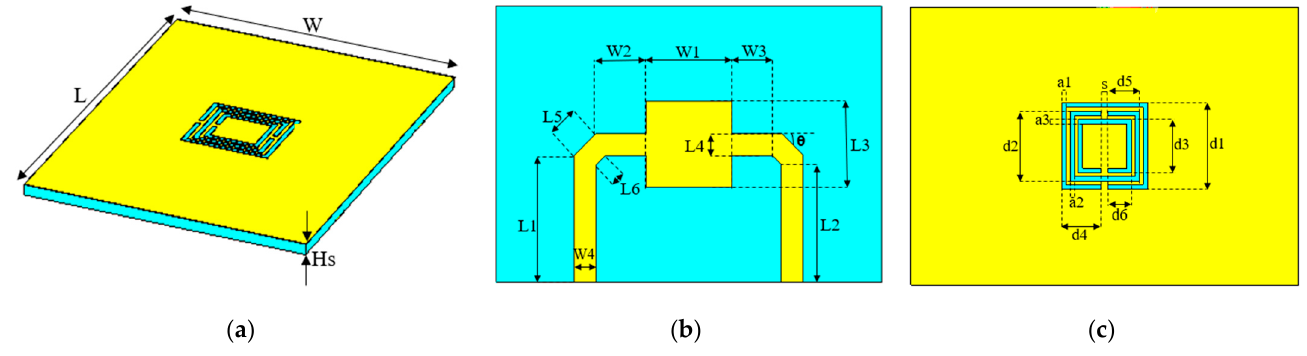
Figure 1. Geometric dimensions of the flat sensor structure [41]: ( a ) side view; ( b ) top view; ( c ) bottom view.